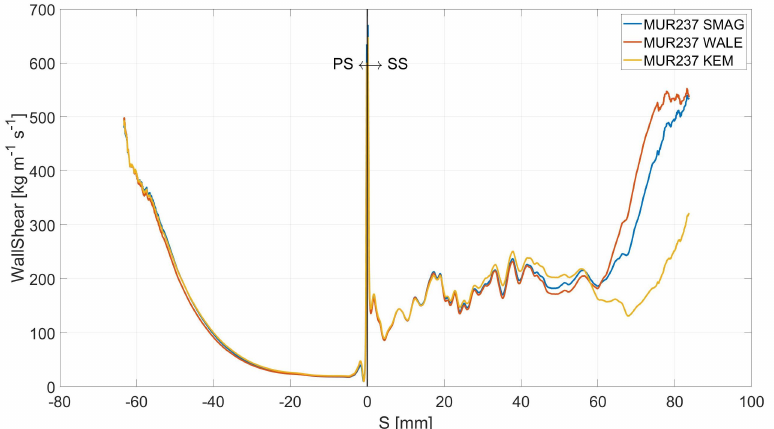
Figure 3. Influence of the SGS closure models: wall shear stress.